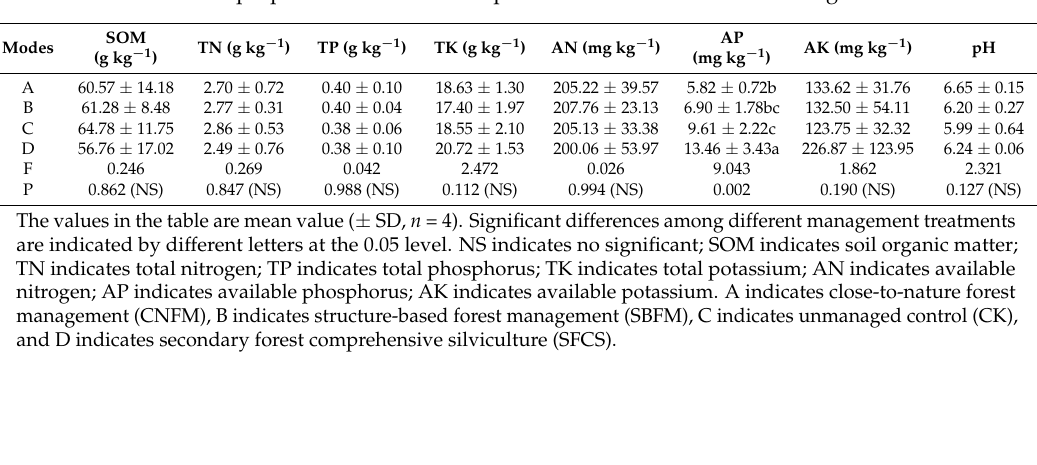
Table 2. Soil chemical properties for the soil sample of forest under different management